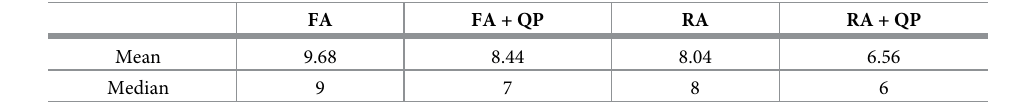
Table 1. Number of runs to find all Heptane isomers.